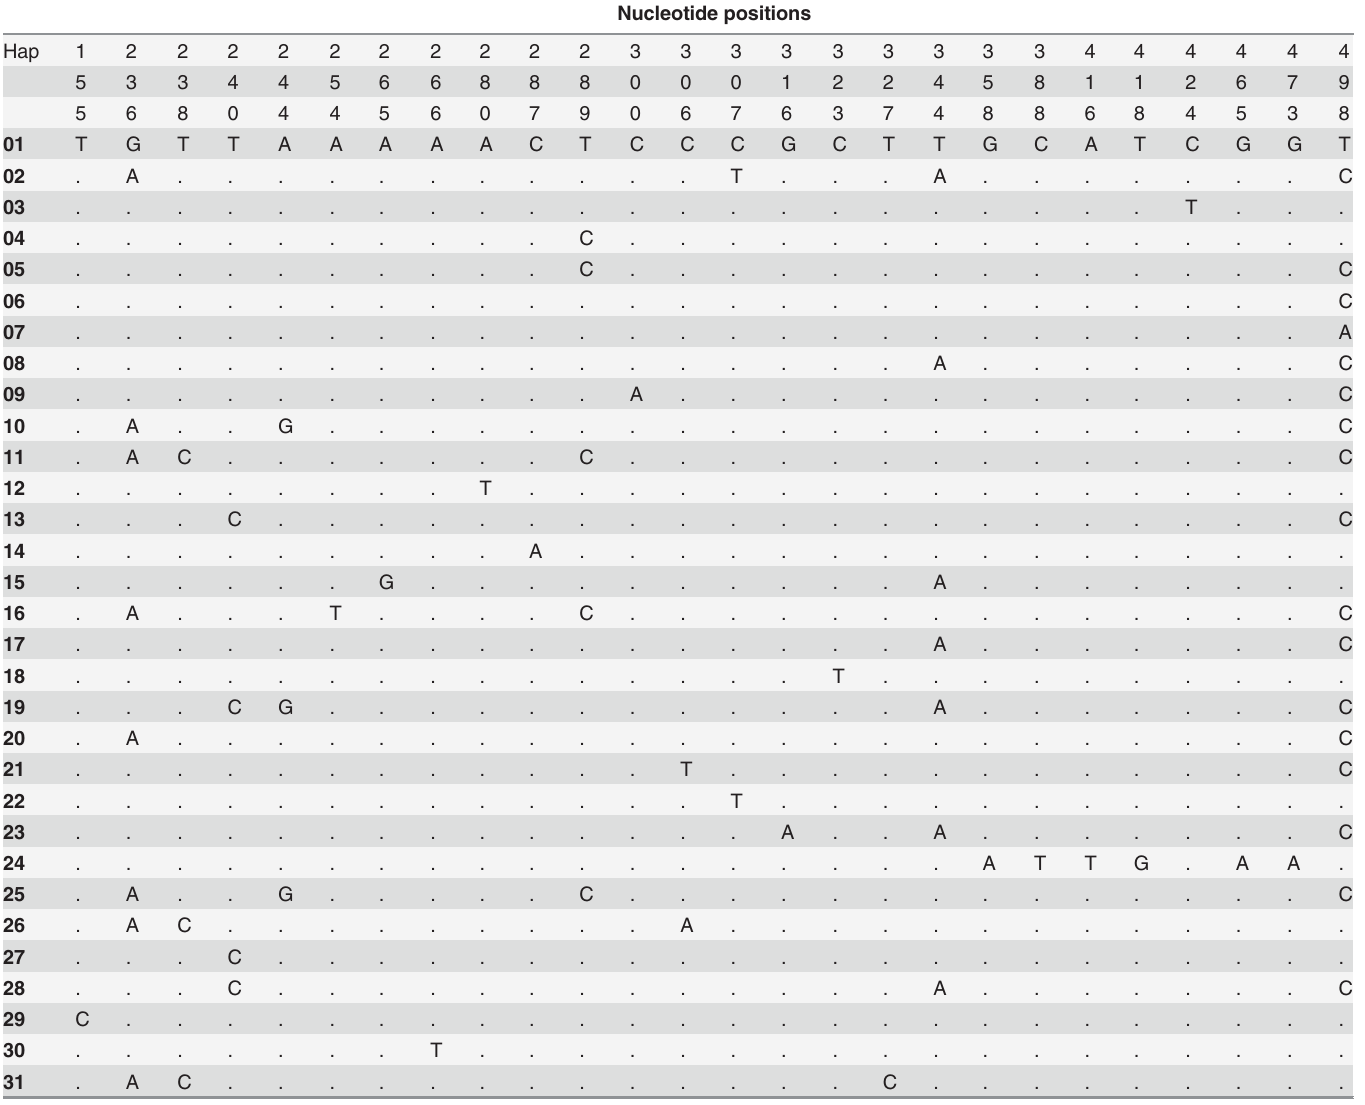
Table 1. Polymorphic nucleotide positions for P. kamoharai